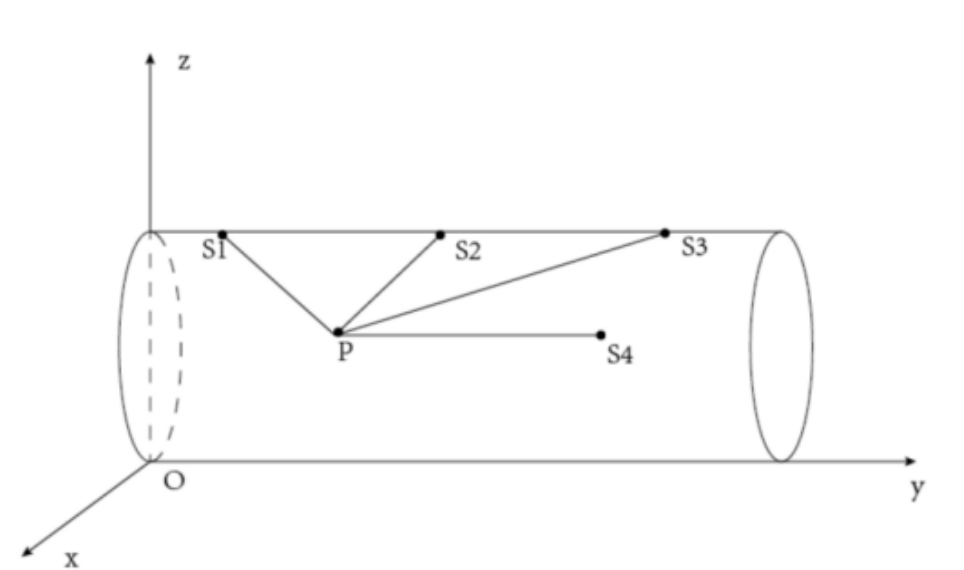
Figure 1. Localization model of GIS